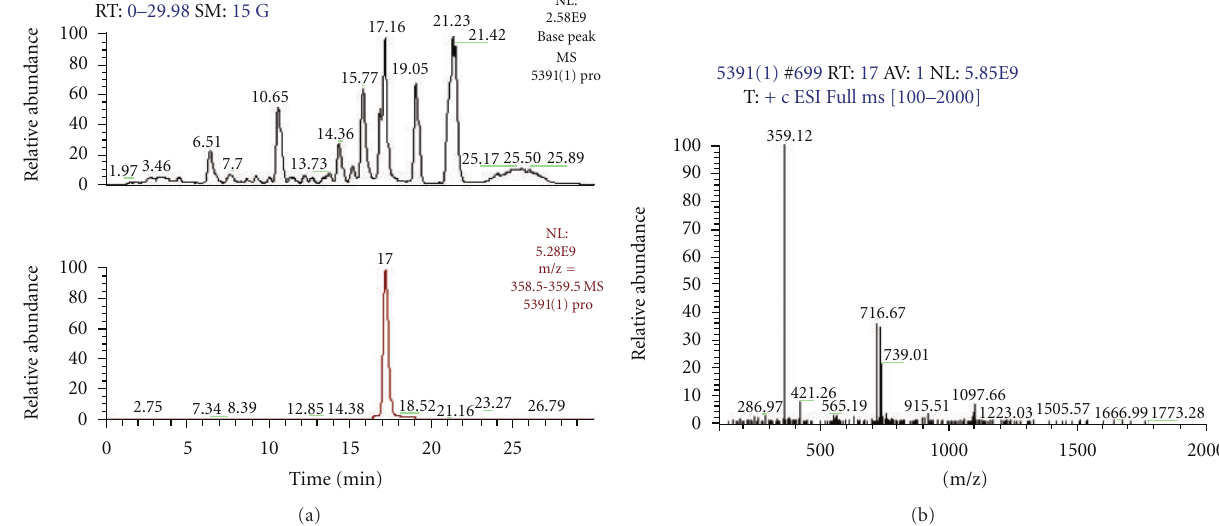
Figure 7: A typical MS chromatogram profile of MFP using M. purpureus FTC5391, which also highlighting the compound with similar RT of MKL standard. (a) MS chromatogram, (b) MS spectrum of compound with similar RT of MKL standard. The MFP was produced by submerged fermentation using Hiroi-PDA (sucrose (100g/L), yeast extract (3g/L), casamino acid (5g/L), NaNO 3 (2g/L), KH 2 PO 4 (1g/L), MgSO 4 · 7H 2 O (0.5g/L), KCl (0.5g/L), FeSO 4 (0.01 g/L), potato starch (4g/L), dextrose (20g/L), and agar (15g/L)).